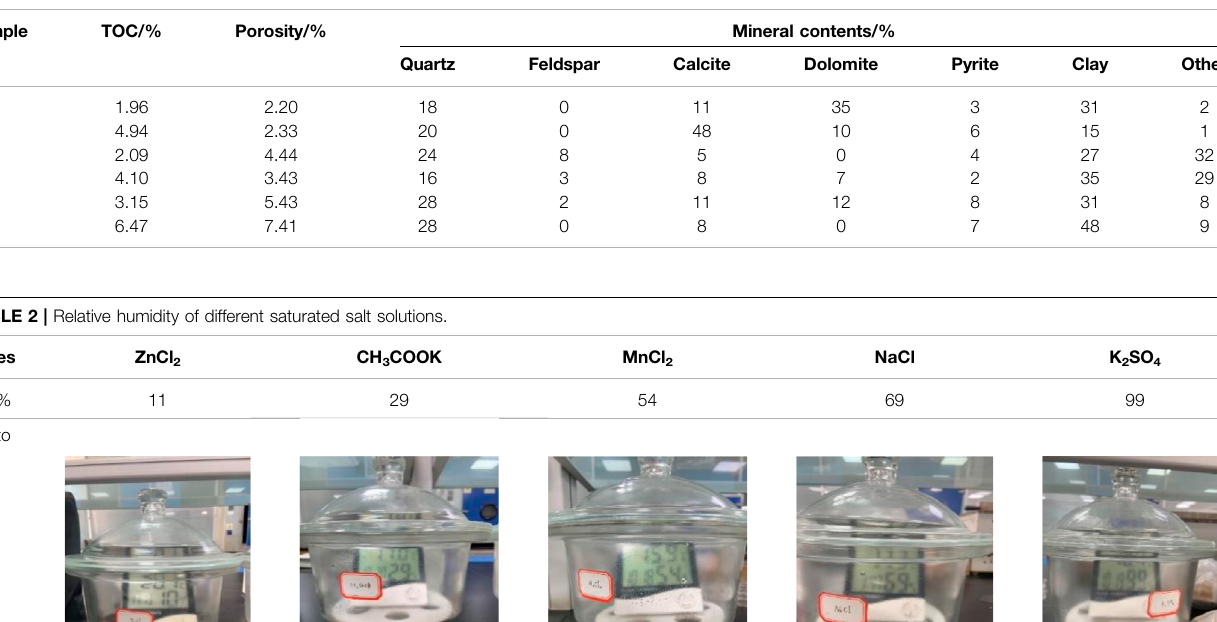
TABLE 1 | Experimental results for shale samples.